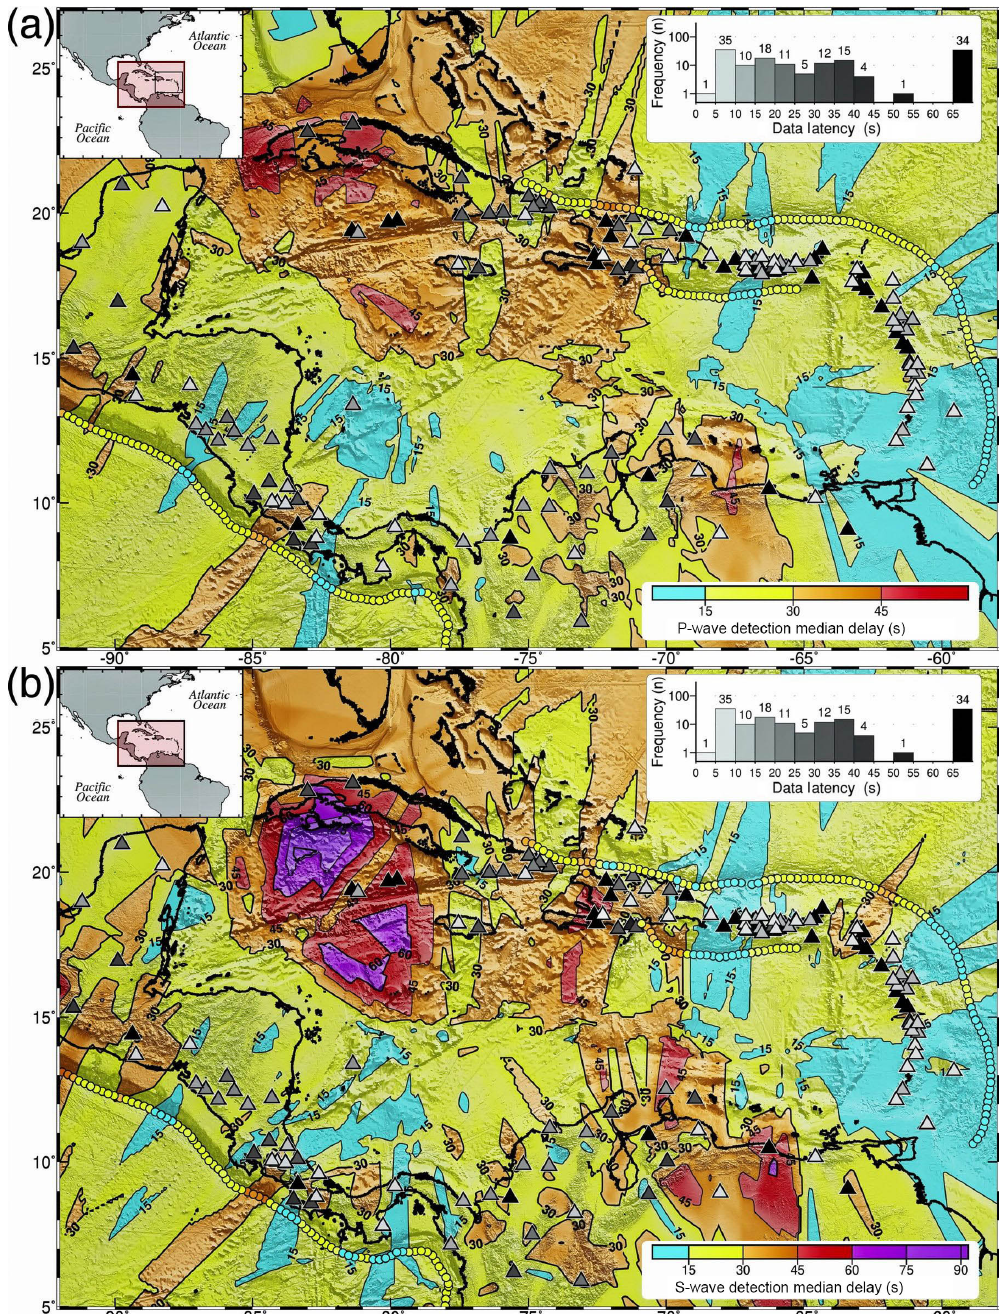
Figure 3. Detection delay in seconds once we account for the effect of data latencies and station outages on the detection time of the first arriving P and S waves after (a) subtracting the P wave detection times shown in Fig. 1a from those in Fig. 1b and (b) subtracting the S wave detection times shown in Fig. 2a from those in Fig. 2b. We can expect outages at 23% (black triangles) and data latencies longer than 10s at 52% of the 146 stations to cause detection delays of at least 15s across 85% of the region. Likewise, we can expect detection delays of more than 30s to affect 28% and 34% of the region in (a) and (b) , respectively. The small, contiguous circles show the computed detection delays sampled every 25 km along the trench